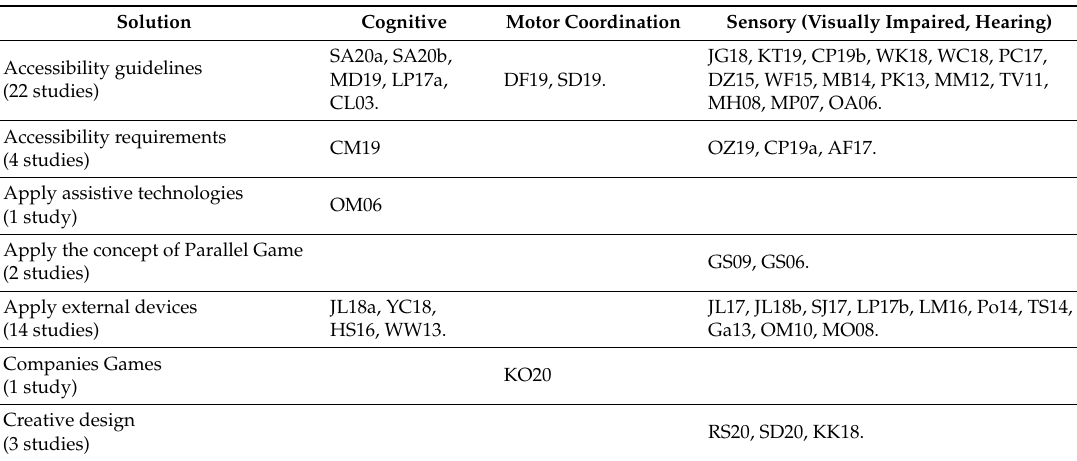
Table 7. The solution to accessibility by type of